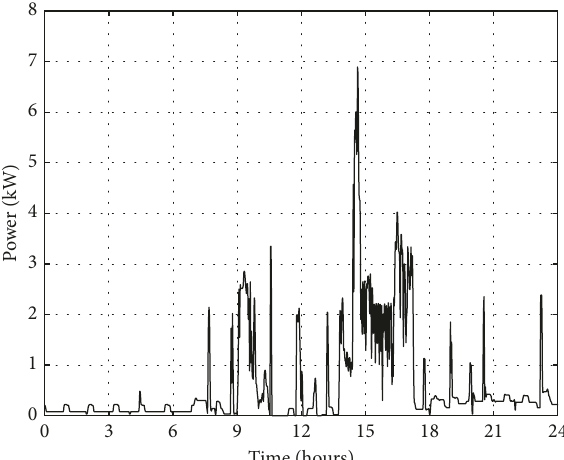
Figure 6: Plot of values after Spritz decryption using Key1 .